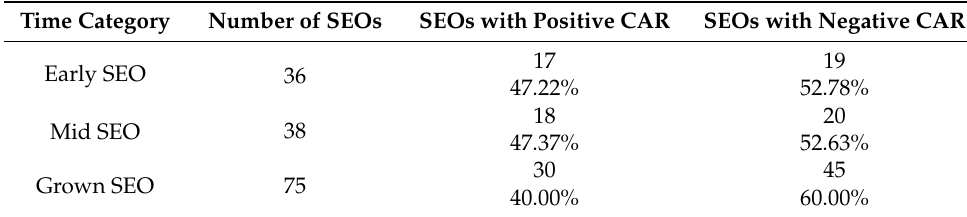
Table 2. Effects of seasoned equity offerings (SEOs) on share price (time categories). Time Category